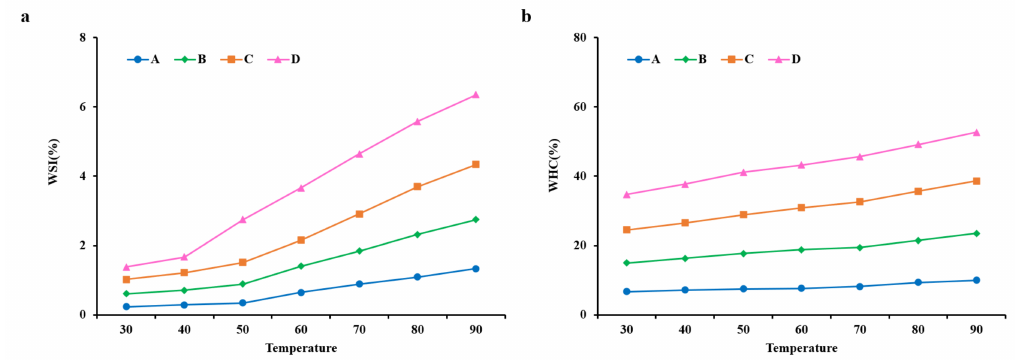
Figure 4. ( a ) WSI, and ( b ) WHC of rice protein.